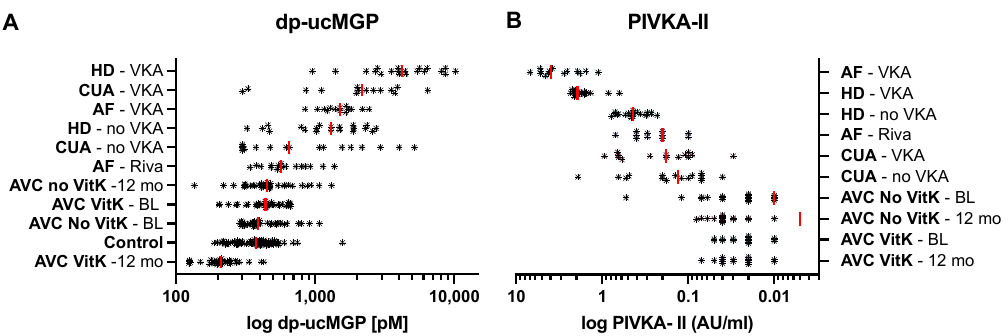
Figure 2. dp-ucMGP and PIVKA-II measurements of all cohorts sorted by median values from high (top) to low (bottom). Red line indicates the median. A : VKA treated patients showed higher dp-ucMGP compared to untreated patients of the same cohort. AVC dp-ucMGP levels were lowest with Vitamin K supplemented patients below the control group. B : PIVKA-II ranks differ from the dp-ucMGP ranks. AF and HD patients showed highest PIVKA-II levels, followed by CUA and AVC.